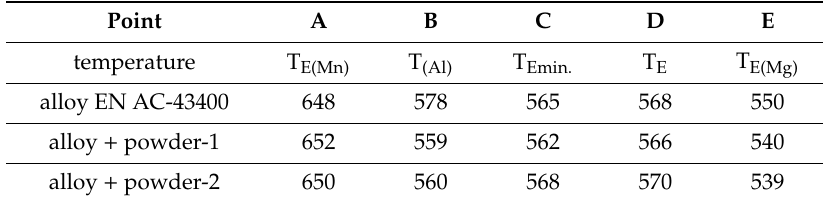
Table 2. Characteristic crystallization temperatures for alloy AlSi10Mg0.5Mn0.5 without addition of powder and after addition of powders ( ◦ C).